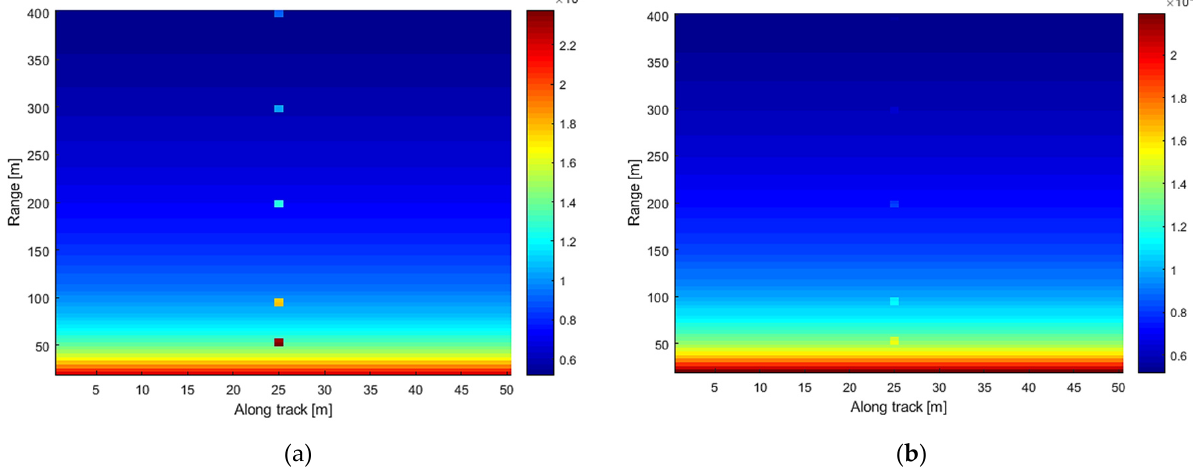
Figure 12. Acoustic scattering fields of a gas bubble with a radius of a = 0.1 in the presence of an infinite cylinder acoustic scattering with a radius of 1 m as a background scattering field at a frequency of 50 kHz and depth of 50, 100, 200, 300, and 400 m as a function of the range and along-track: ( a ) Using the proposed coherent method at a range migration R m ; ( b ) non-coherent methods at broadside range r 0